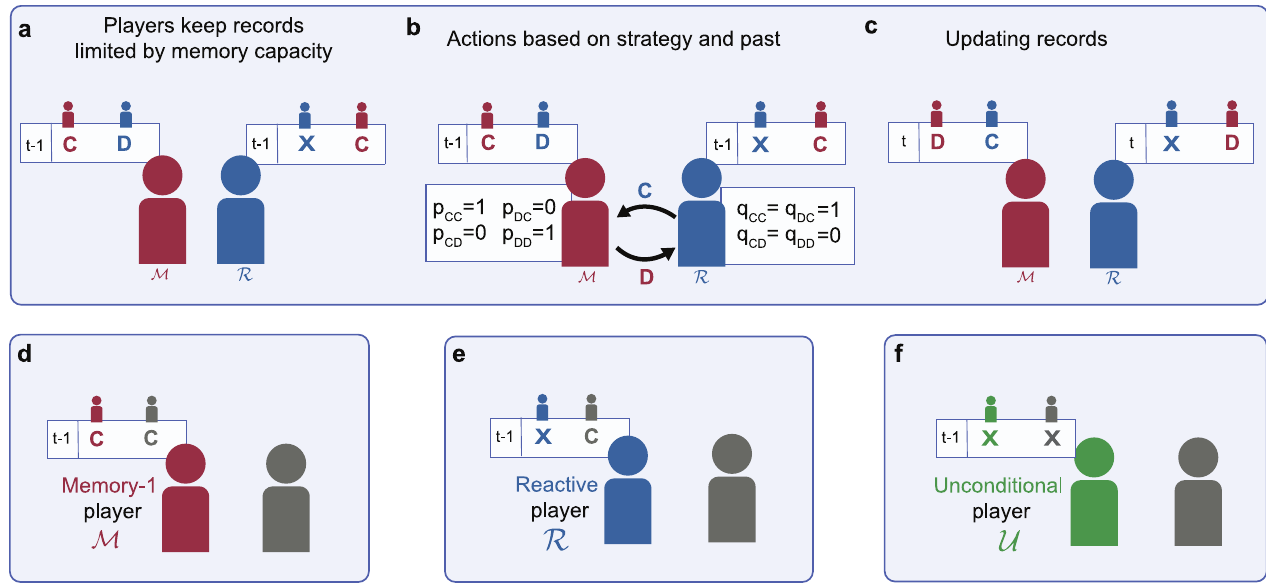
Fig 1. Direct reciprocity among players with different memory capacities. a-c , Models of direct reciprocity assume that two or more players repeatedly engage in a social dilemma. In each round t , players can either cooperate ( C ) or defect ( D ). To make these decisions, players keep a record of what happened in previous rounds. Based on these records, they decide whether or not to cooperate in the current round. After each round, players update their private records. These records may be constrained by how much players remember. Here we distinguish three memory spaces. d , Memory-1 players ( M ) remember both their own and their co-player’s previous action. e , Reactive players ( R ) only remember their co-player’s previous action. f , Unconditional players ( U ) keep no records at all. The example in the first row illustrates an interaction between a memory-1 player with strategy WSLS [16] against a reactive player with strategy TFT